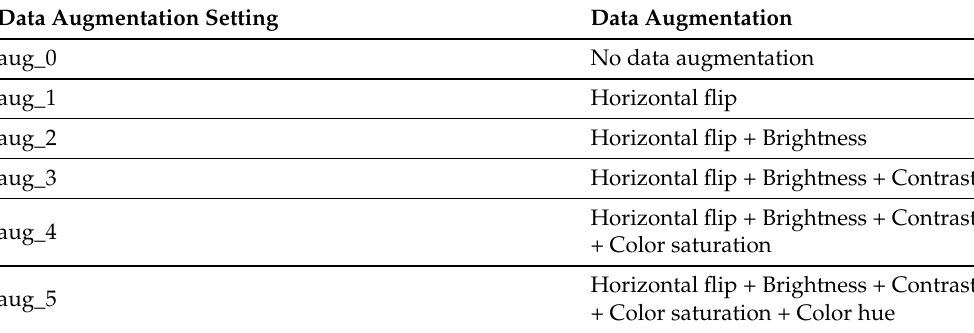
Table 1. Table of notations used for data augmentation with different setting enabled.